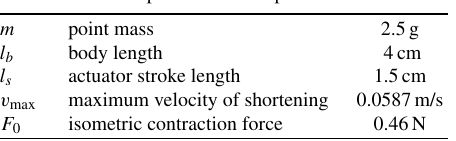
Table 2 Muscle-powered model